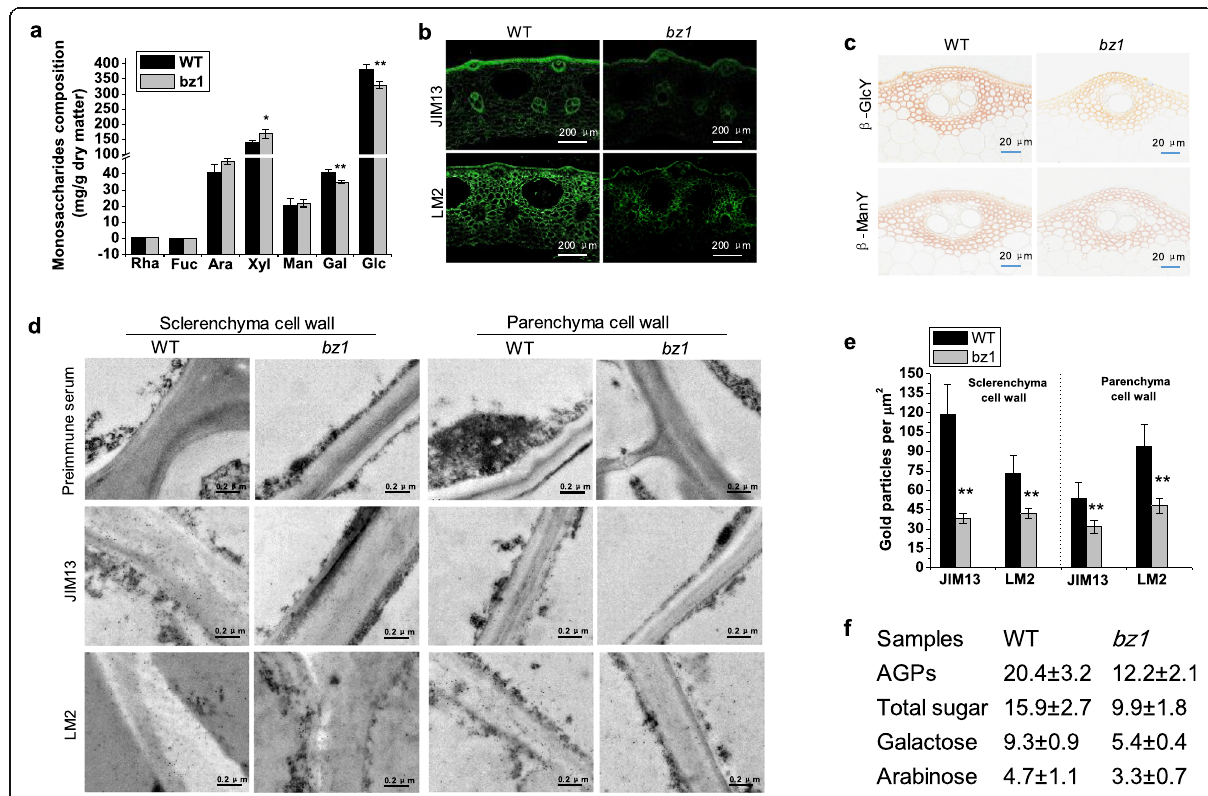
Fig. 3 The bz1 mutant displays impaired AGPs biosynthesis. a Comparison of monosaccharides composition of mature stem between wild-type (WT) and bz1 plants. * and ** indicates significant differences between WT and bz1 by t -test at P < 0.05 and 0.01, respectively. b Immunohistochemical analysis of AGPs in culm sections using JIM13 and LM2 monoclonal antibodies. The bz1 shows substantially weaker signals than WT in all cells including the vascular bundle, sclerenchyma and parenchyma cells. c Staining of hand-cut stem sections with β GlcY and β ManY (control). The bz1 shows weaker signal than the WT. d Immunogold labeling of sclerenchyma and parenchyma cell walls of WT and bz1 plants with JIM13 and LM2 monoclonal antibodies. e The bz1 shows fewer particles in both sclerenchyma and parenchyma cell walls. f Comparison of the abundance of AGPs and its monosaccharides composition in WT and bz1 . The AGPs content was measured and calculated as μ g g − 1 fresh weight of tissue. The results are means ± SE of three independent